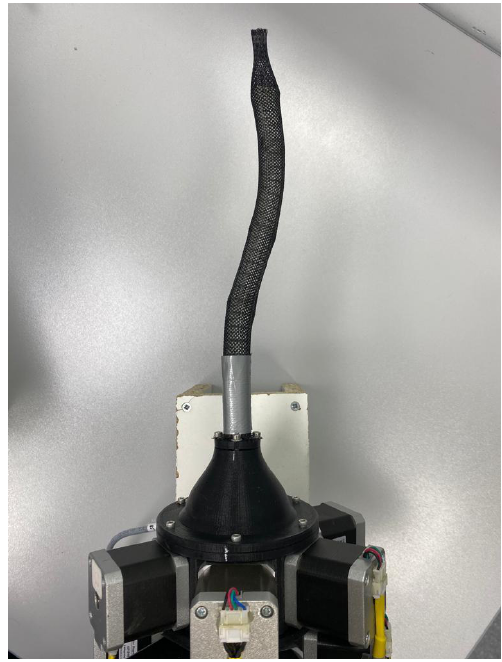
Figure 28. Pilory, a continuous hyper-redundant